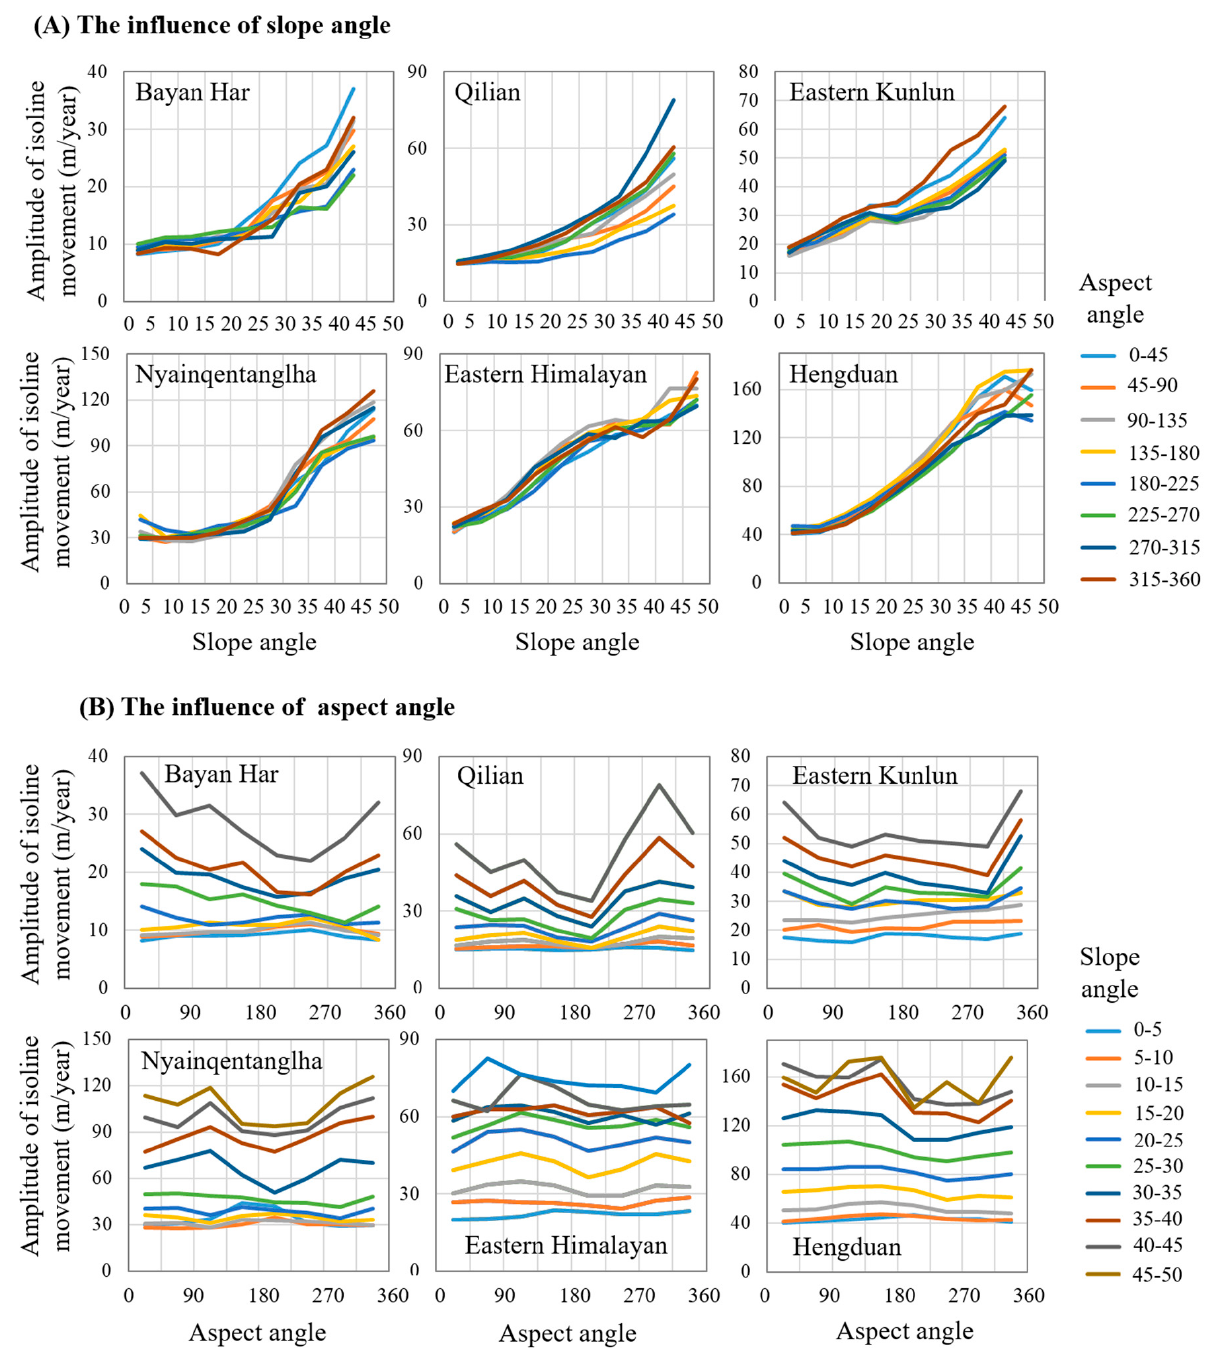
Figure 10. The amplitude of elevational movement of NDVI isoline under different ( A ) slopes and ( B ) aspects in the six mountainous regions. Slopes and aspects were sampled at the interval of 5° and 45°, respectively.